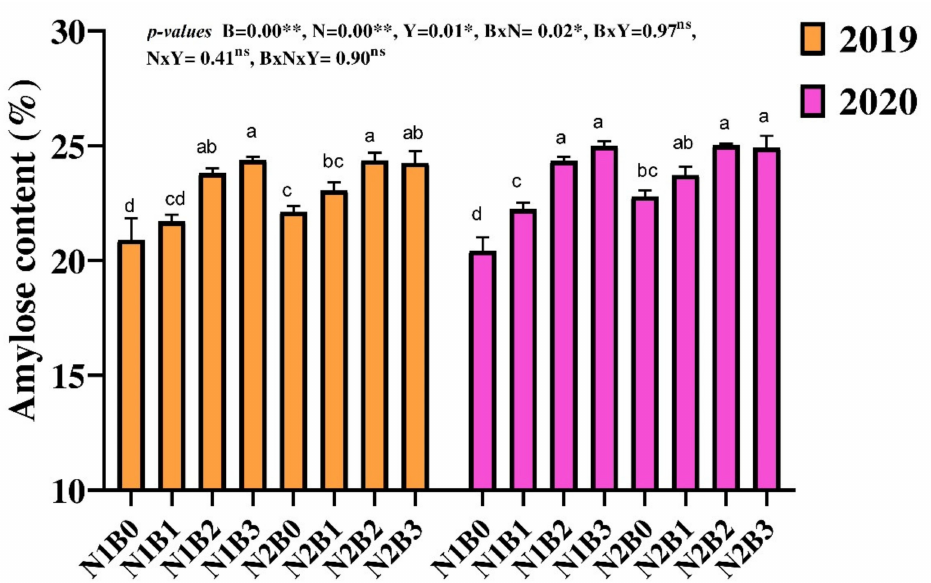
Figure 3. Changes in amylose content of rice in response to different biochar and nitrogen fertilizer. Different letters above the column are significantly different from each paper. Bars represent the standard errors of the means. ** and * on the B, N, and Y indicate significance at the 0.01 and 0.05 probability levels, respectively. ns: non-significant. Columns with different letters are significantly different at p < 0.05. N1 and N2 represent 135 and 180 kg ha − 1 nitrogen; B0, B1, B2, and B3 represent 0-, 10-, 20-, and 30-ton biochar ha − 1 .